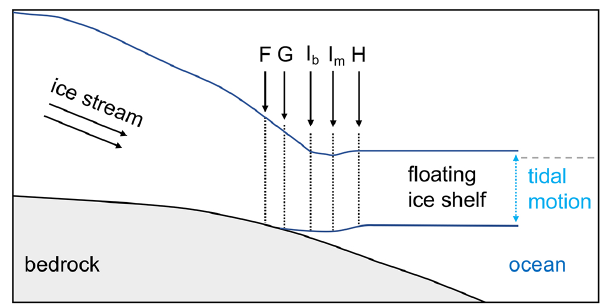
Figure 1. Schematic diagram of the ice shelf grounding zone (GZ) structure adapted from Fricker and Padman (2006). Point G is the true grounding line where the grounded ice first comes into contact with the ocean, Point F is the landward limit of ice flexure caused by ocean tidal movement, Point H is the seaward limit of ice flexure and the inshore limit of hydrostatic equilibrium, Point I b is the break in surface slope, and Point I m is the elevation minimum inside the